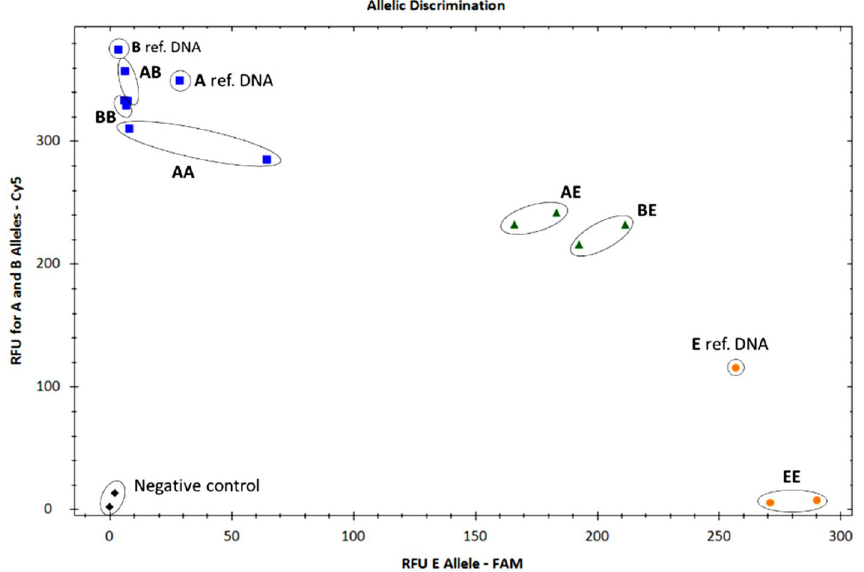
Figure 3. Allelic discrimination graph of 13124-qPCR assay for AA, AB, BB, BE and EE genotyped DNA samples from hair follicles of genotyped animals. The blue dots represent the heterozygous AB genotype and the homozygous AA and BB genotypes (Cy5 reporter), the greens dots represent heterozygous AE or BE genotypes, the yellow dots represent the homozygous EE genotype; the black dots represent negative control (NTC). A, B and E synthetic reference samples were used as a positive control of the assay. Data were plotted using RFU of the FAM reporter dye of E allele on the x axis and using RFU of the cy5 reporter dye of A and B allele on the y axis. RFU = relative fluorescence